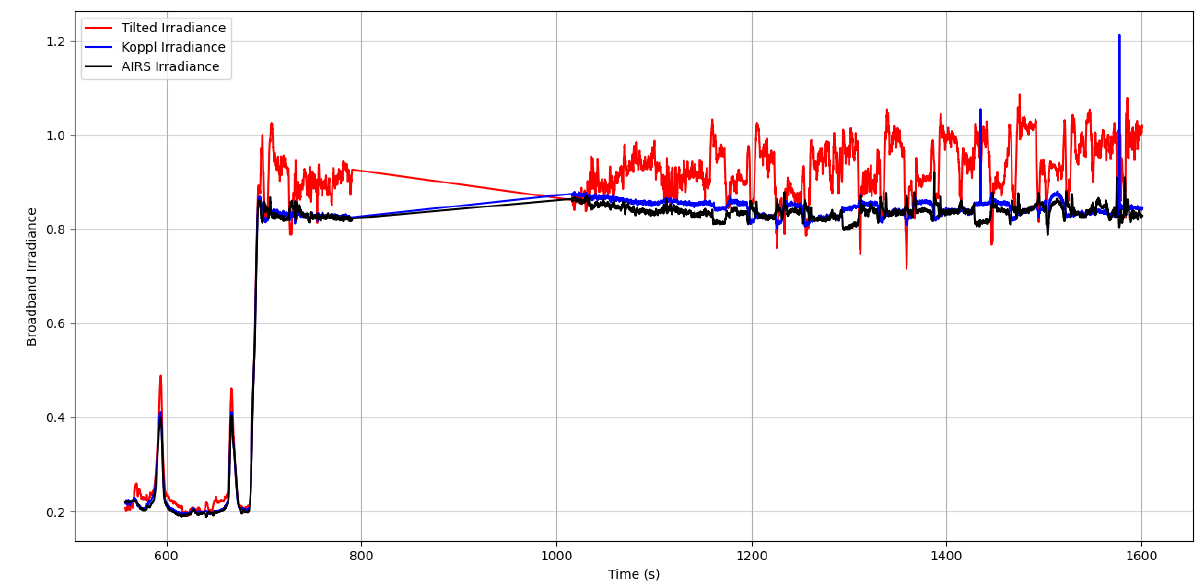
Figure 7 . Time series of tilted and tilt-corrected irradiances